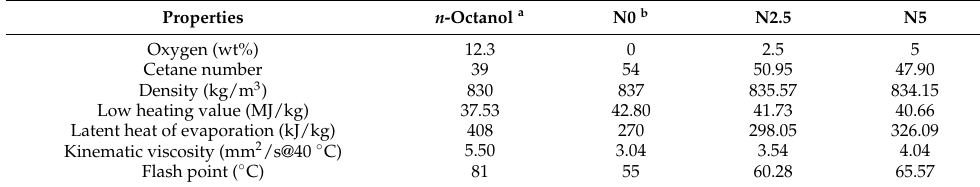
Table 3. Properties of blending fuels